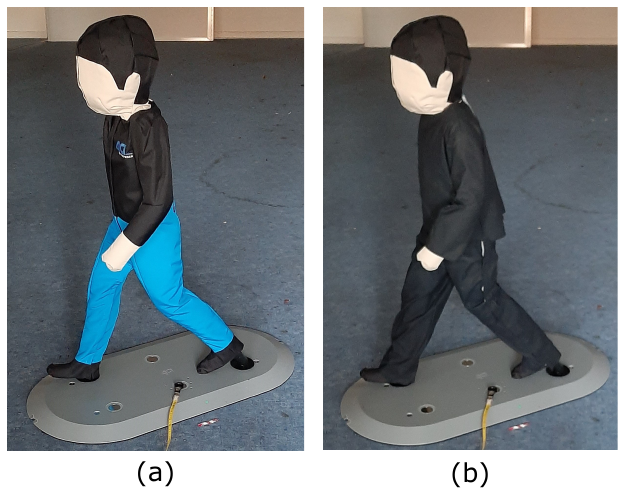
Figure 2. ( a ) Test target “4activePS child (v3v3.2)”; ( b ) modified test target with